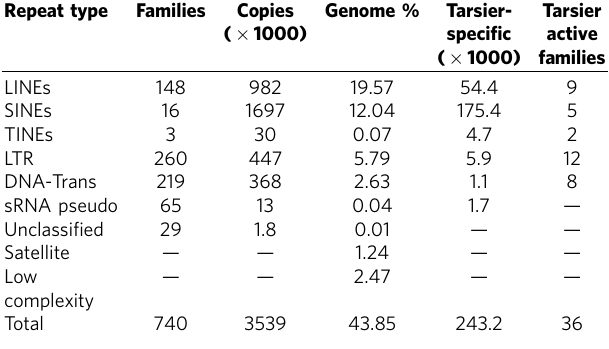
Table 1 | Repeat element landscape and selected pseudogenes of Tarsius syrichta (detailed landscape is presented in Supplementary Table